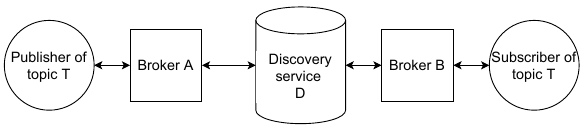
Figure 3. Running example